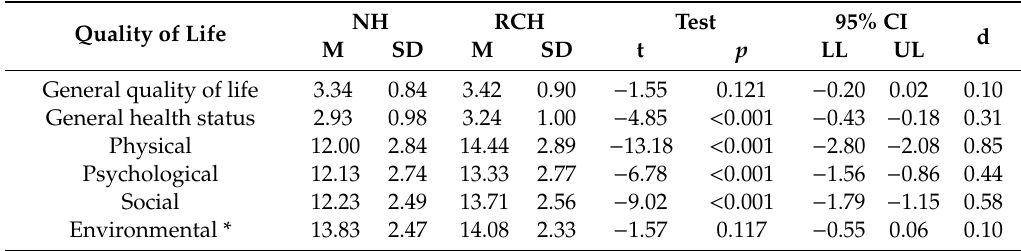
Table 4. Comparison of the quality of life depending on the type of care